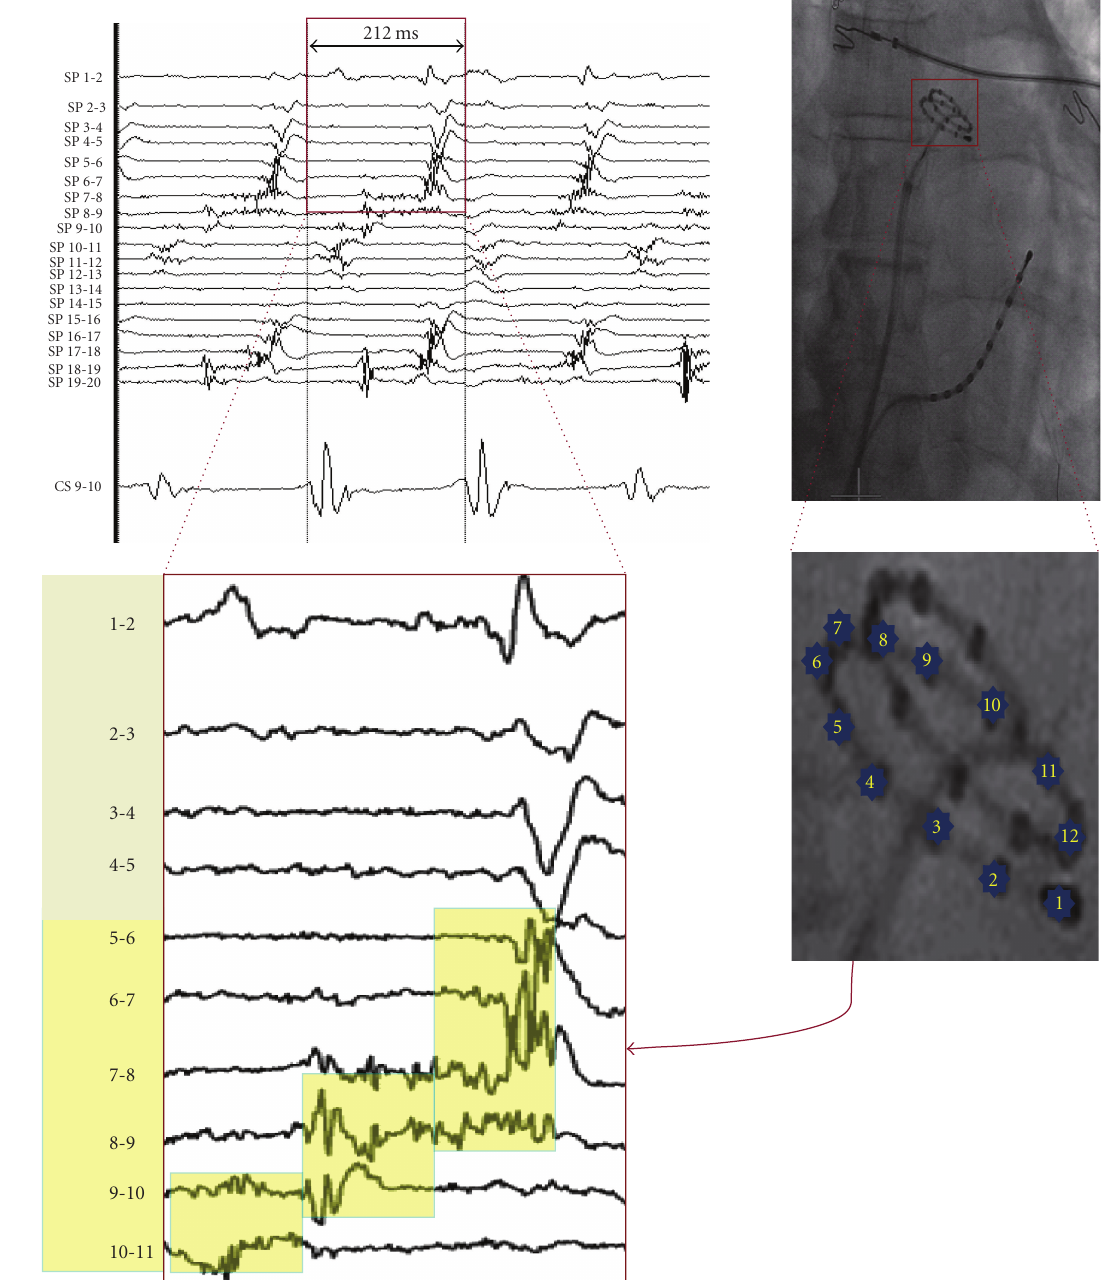
Figure 1: Cardiac fluoroscopy in posteroanterior view shows a multipolar spiral catheter (20mm diameter) and a decapolar catheter. The spiral catheter is mapping left atrial roof. Within a small area of ∼ 3 cm 2 , electrical activity spanning across almost the entire cycle length (212ms) of tachycardia is demonstrated on bipolar electrograms recorded from dipoles 4-5 to 10-11 on the spiral catheter (yellow background in the zoom). The electrograms are low voltage with maximum amplitude − 0.2 mV. This is characteristic of localized reentrant form of focal atrial tachycardia. Instead of a point source, small area harbours tiny circuit which sustains entire cycle length of reentrant tachycardia. The remainder of the atria is activated centrifugally which is consistent with focal tachycardia. Simultaneous recording of dipole 9-10 of decapolar catheter in coronary sinus is also